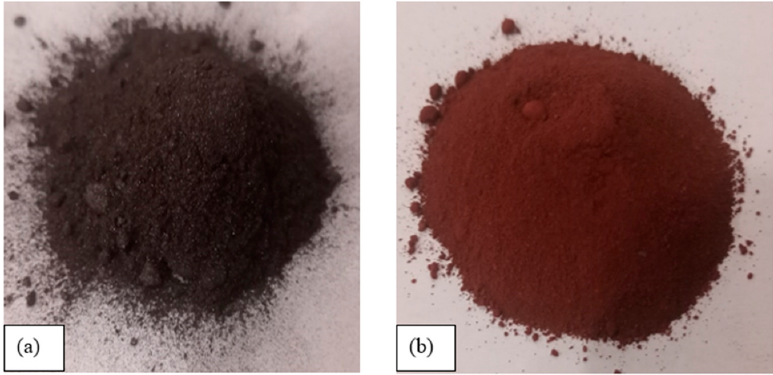
Figure 6. Difference in appearance of (a) processed and (b) raw/unprocessed ore.